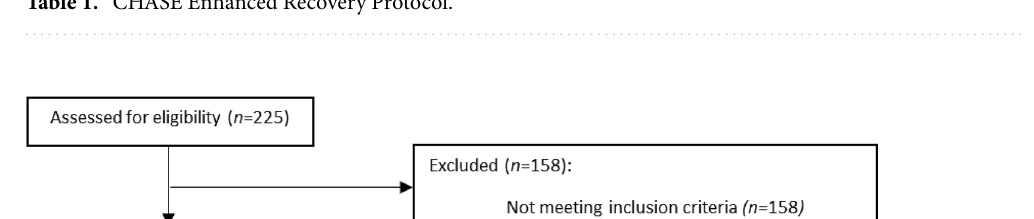
Table 1. CHASE Enhanced Recovery Protocol.